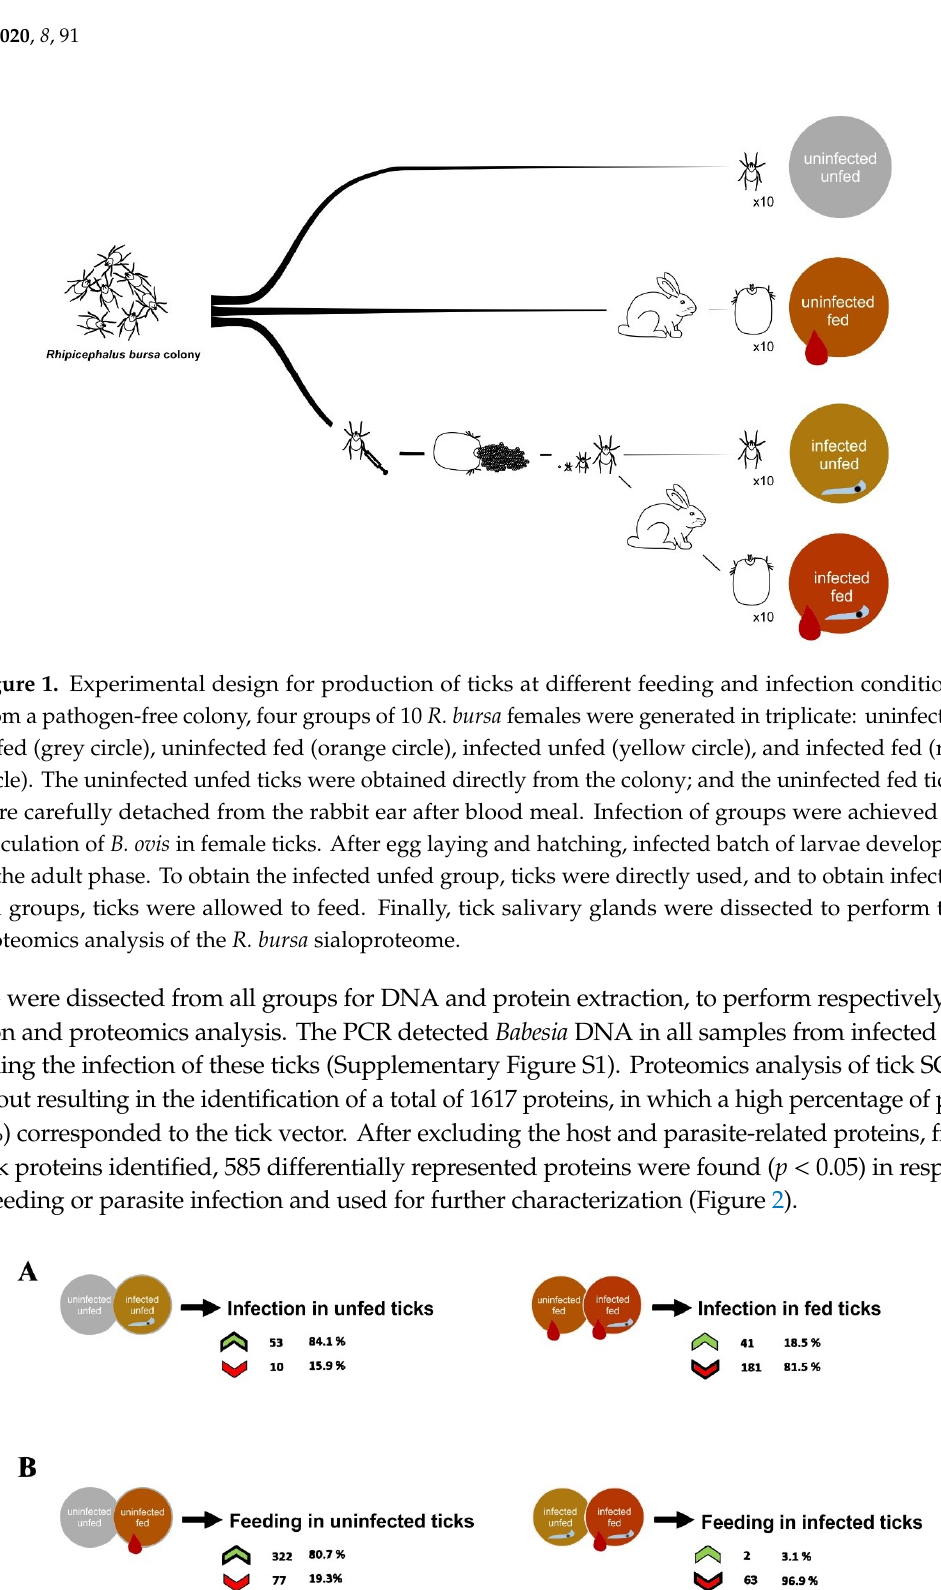
Figure 2. Di ff erentially represented proteins from the R. bursa sialoproteome after infection ( A ) and blood feeding ( B ). For each condition it is represented the process of infection (parasite) and feeding (blood drop), as well as the number and percentage of proteins di ff erentially over (green arrow) and under (red arrow) represented in R. bursa salivary glands. Grey circle + no symbols = uninfected and unfed ticks, yellow circle + parasite = infected and unfed ticks, orange circle + blood drop = uninfected and fed ticks, red circle + parasite + blood drop = infected and fed